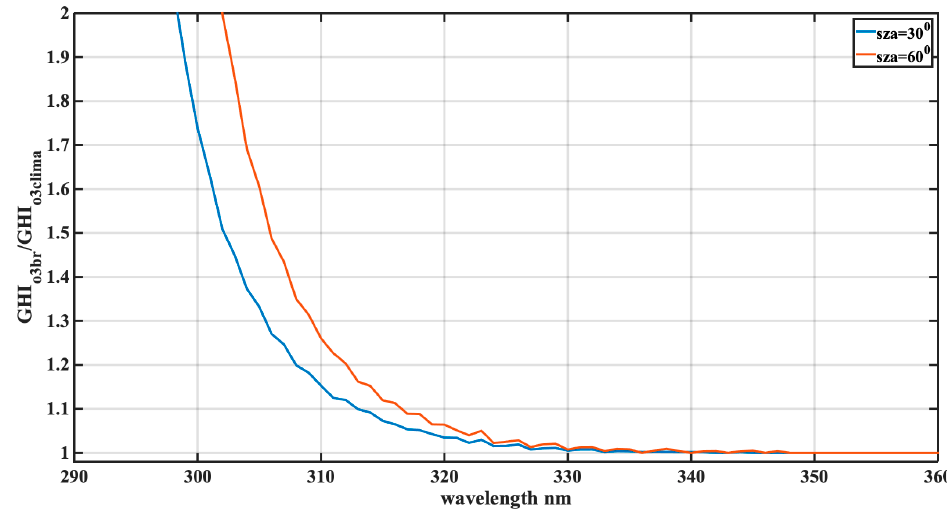
Figure 8. Ratio of modeled spectra in the UV region, as derived from RTM, with mean TOC measured by BRS on 15 May 2020, and climatological TOC, at two solar zenith angles. Atmosphere 2021 , 12 , x FOR PEER REVIEW In Figure 9, in order to show the AOD effect, modeled spectral ratios of GHI simulated with AOD = 0.5 and AOD = 0 at SZA = 30° and 60° are presented. In all the above runs,